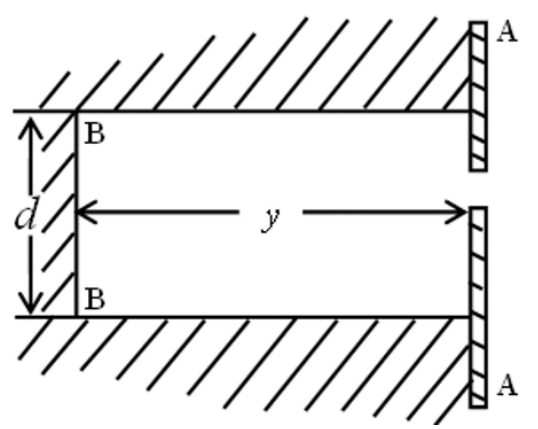
Figure 2. Typical resonance unit of a single degree of freedom Helmholtz resonant type of liner.